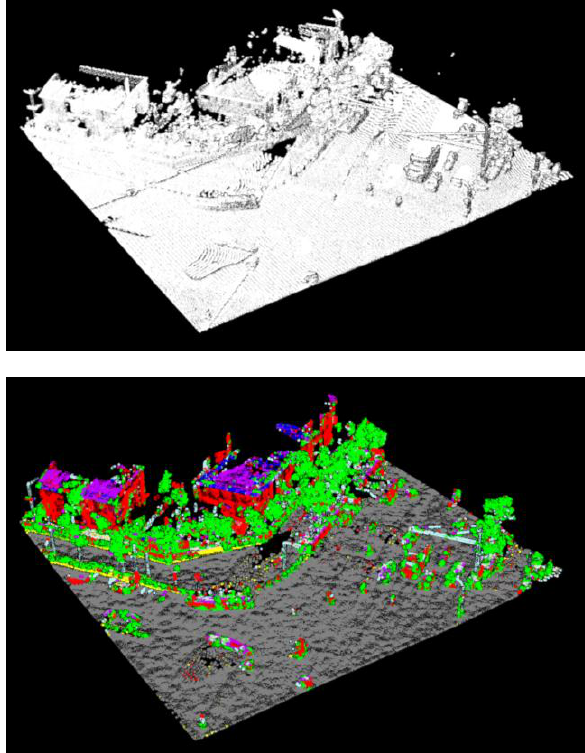
Figure 3. MMS point cloud (top) & MMS point cloud after classification (bottom)